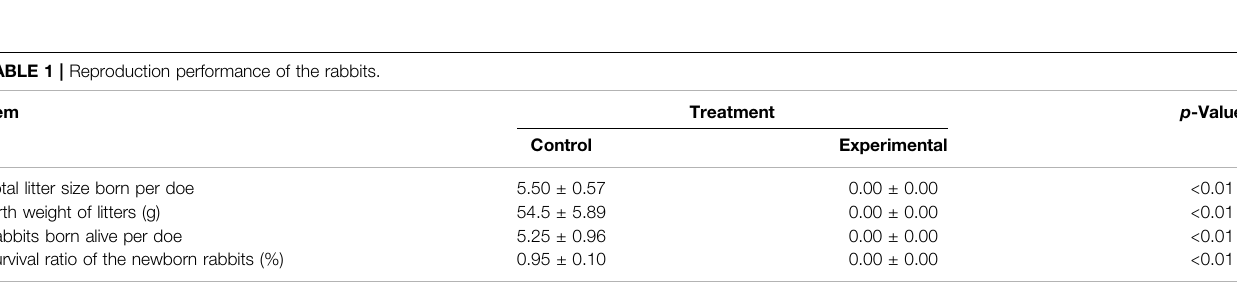
check the status of pregnancy of the animals. As shown in Supplementary Figure S1 , compared with non-pregnant rabbits, embryos in the rabbits of the control group and coprophagy prevention group were clearly detected, indicating that rabbits in both groups were all pregnant.